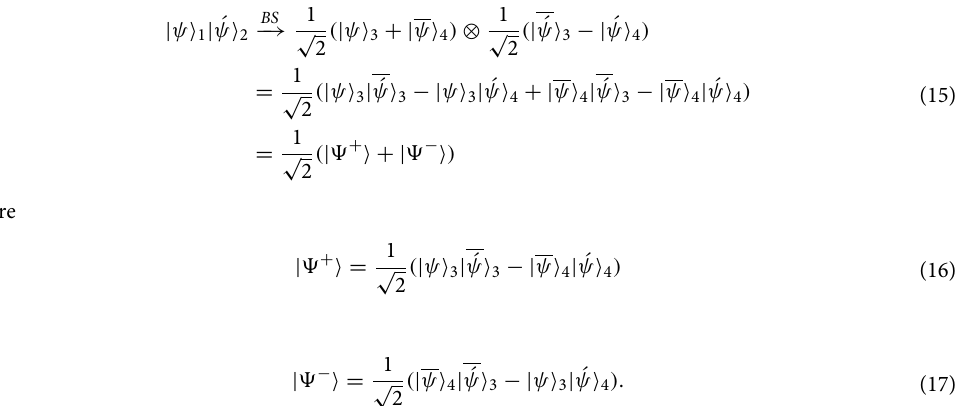
photons creating the biphoton. Each Brown Twiss scheme is tuned to detect a certain polarization state of biphoton by setting wave plates ( (cid:31) / 4 plate, (cid:31) / 2 plate) to angle positions that realize desired polarization and setting polarization analyser to allow the desired polarization to pass through. Different angle settings for wave plates are shown in Table 2. When a Brown Twiss scheme is tuned to the settings for detection of specific polari- zation states, the orthogonal biphoton states cannot result in coincidence detection. For instance, in the Brown β Twiss scheme used to detect biphoton mode, there are two detectors for the horizontal polarization contribu- | � tions from Alice and Bob’s biphoton states which are labelled as D HA and D HB . Furthermore, there are two detectors for measuring the vertical polarization contributions of biphoton states from Alice and Bob labelled as D VA and D VB as shown in Fig. 3. Similarly, appropriate parameters are set in the filters of both arms of the Brown Twiss scheme for detecting other states to allow coincidence detection. Note that states prepared by Alice β γ α and Bob are a superposition of the three basic states , and . Therefore, a successful Bell state measure- | � | � | � ment in the Brown Twiss scheme corresponds to the observation of precisely 12 detectors being triggered; for α instance, D H 1 A , D H 1 B , D H 2 A and D H 2 B (associated with biphoton mode), D H 3 A , D H 3 B , D V 4 A and D V 4 B | � L (associated with β γ α which represent a click in detectors on the left-hand side for , and modes (i.e., D α denotes coincidence L | � | � | � β γ α α detection in detectors of mode) or a click on the right-hand side for , and modes detectors. A con- | � | � | � | � clusive result is given by click in detectors of the mode sorters on the left-hand side or the right-hand side